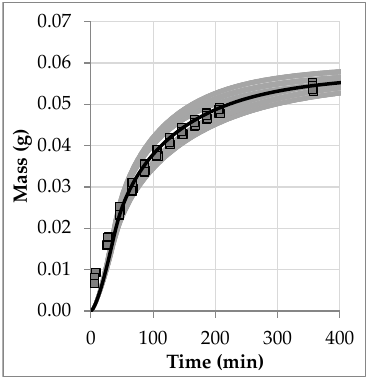
Figure 8. Sensitivity analysis, DoE.